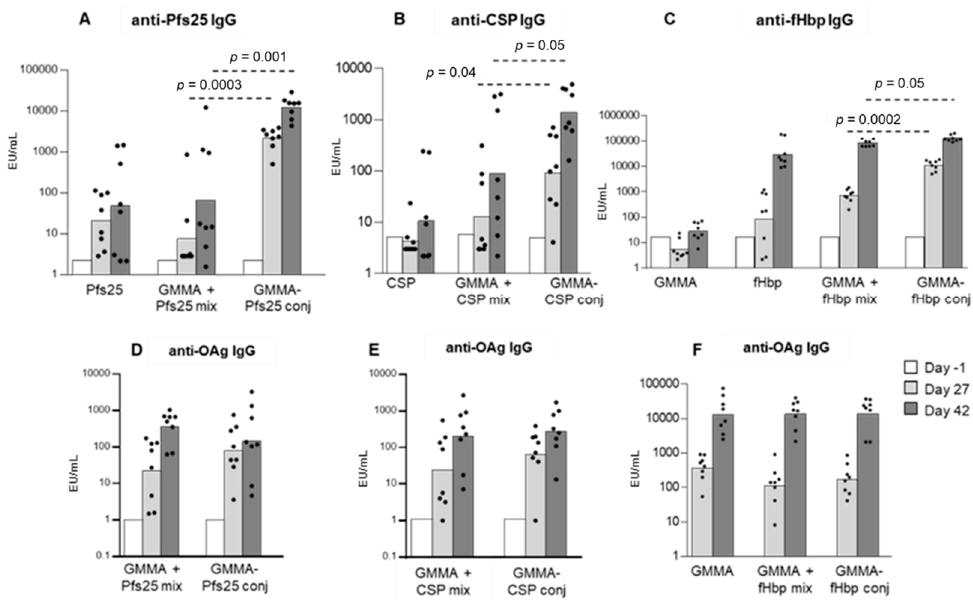
Figure 1. GMMA as a carrier for protein antigens: antigen-specific IgG response. Eight CD1 mice per group were s.c. immunized at days 0 and 28, with S. Typhimurium GMMA conjugates of Pfs25 (0.1 µg Pfs25/dose), CSP (0.1 µg CSP/dose) or fHbp (0.75 µg fHbp/dose). Protein antigens, GMMA alone or their physical mixtures were used as controls. Formulations were tested with Alhydrogel. Sera were collected at days -1, 27 and 42 and analyzed for anti-protein antigen-specific IgG response ( A – C ) and anti-OAg IgG response ( D , E ). Summary graphs of anti-antigen-specific IgG geometric mean units (bars) and individual antibody levels (dots) are reported. In graphs ( D – F ), no significant differences in ELISA units were observed. Datasets were analyzed using a two-tailed nonparametric Mann–Whitney test . p -values (rounded to the nearest larger number) less than 0.05 were considered statistically significant.